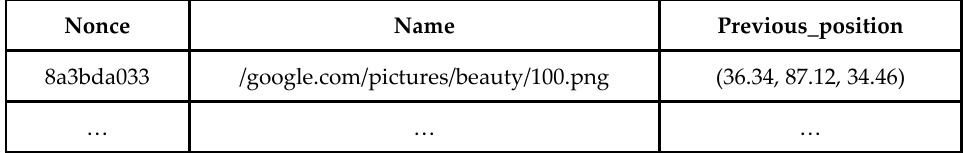
Figure 6. Pending Interest Table (PIT) and an example entry.